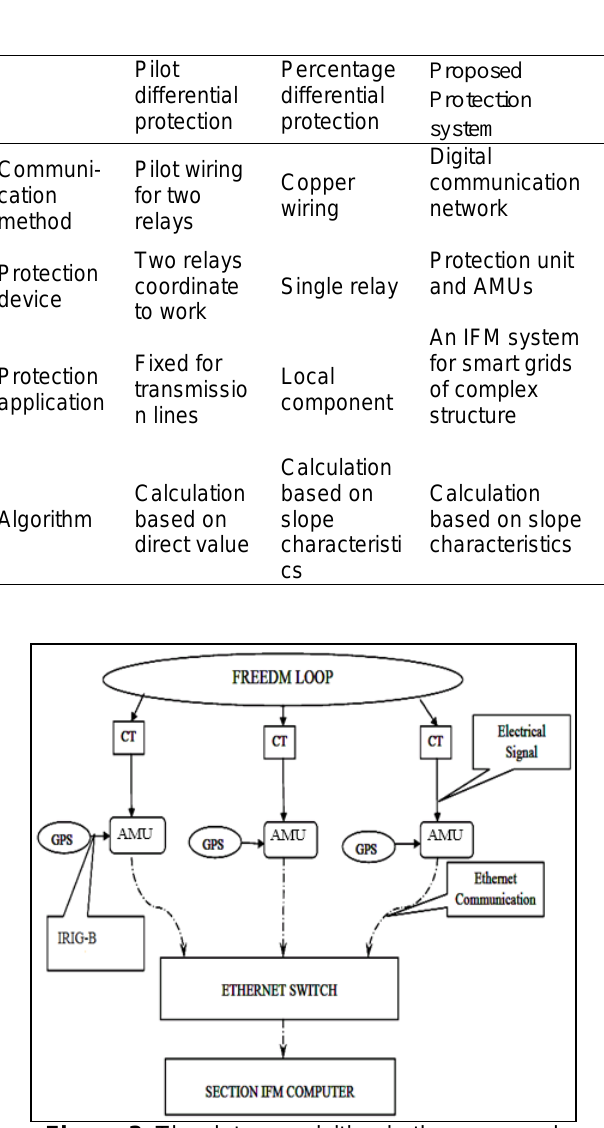
Table 1. Comparison of the three protection methods